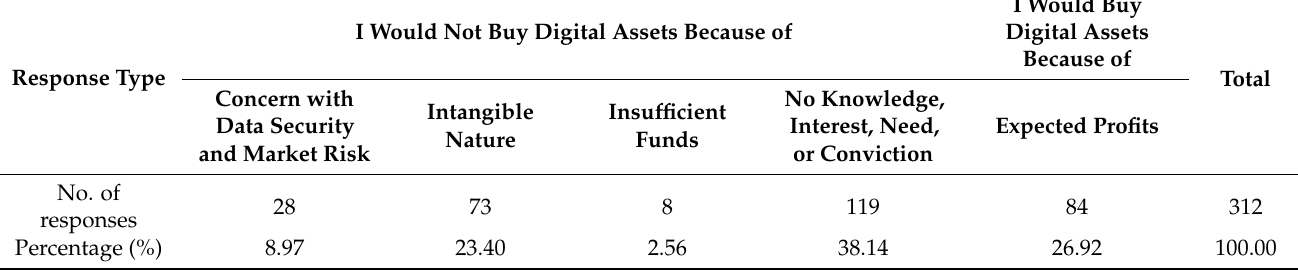
Table 3. Responses to the second question: Why would you be inclined (or not) to buy digital assets?